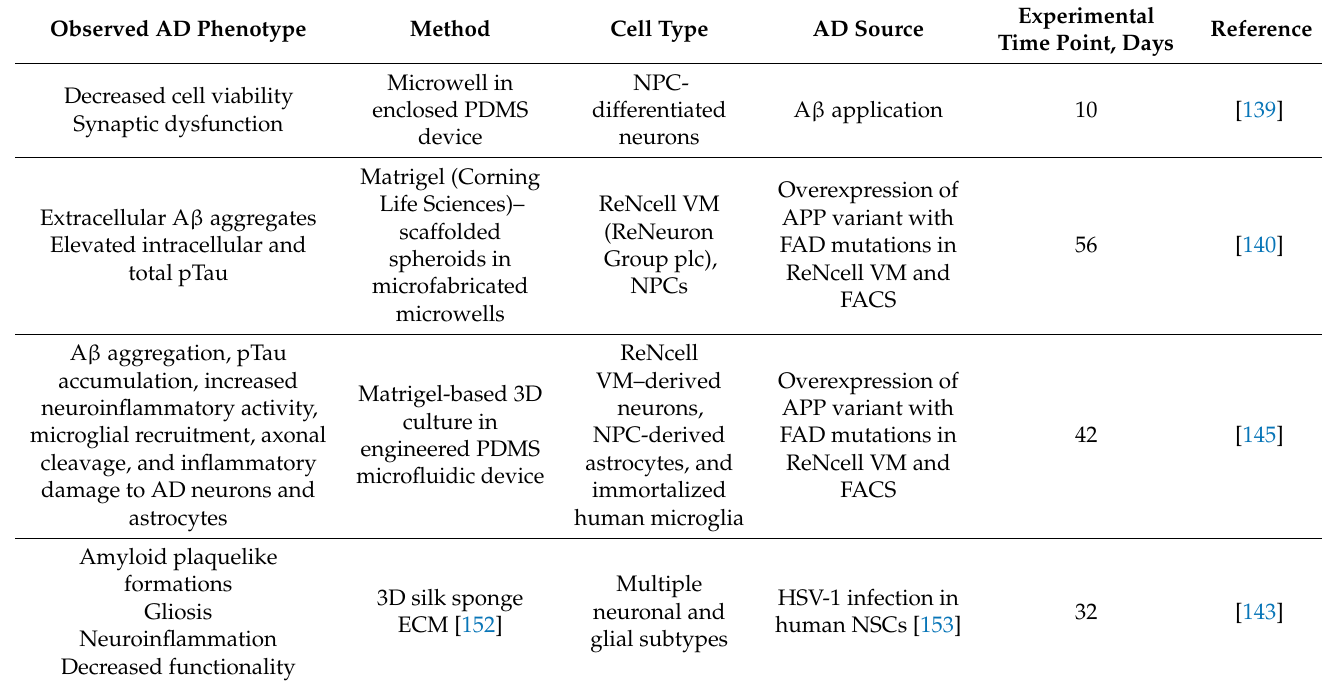
Table 3. Engineered 3D models of AD.